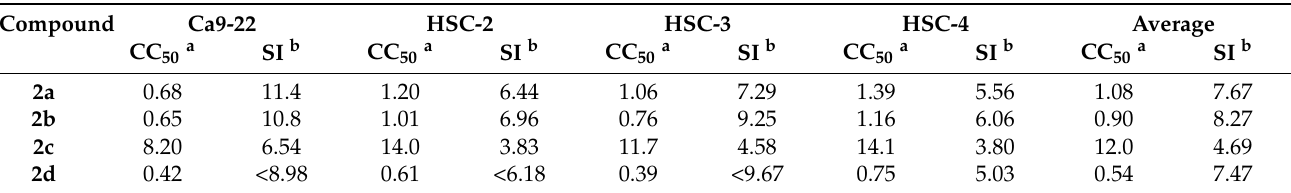
Table 1. Evaluation of 1 , 2a – f , and 3a – e against human HCT116 and HT29 colon cancer cells and human CRL1790 colon cells.